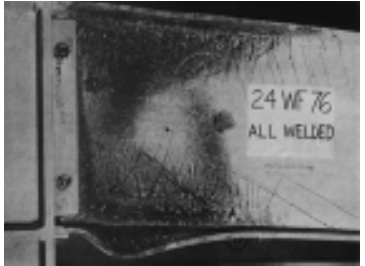
Fig. 16. Specimen of the first experiment after